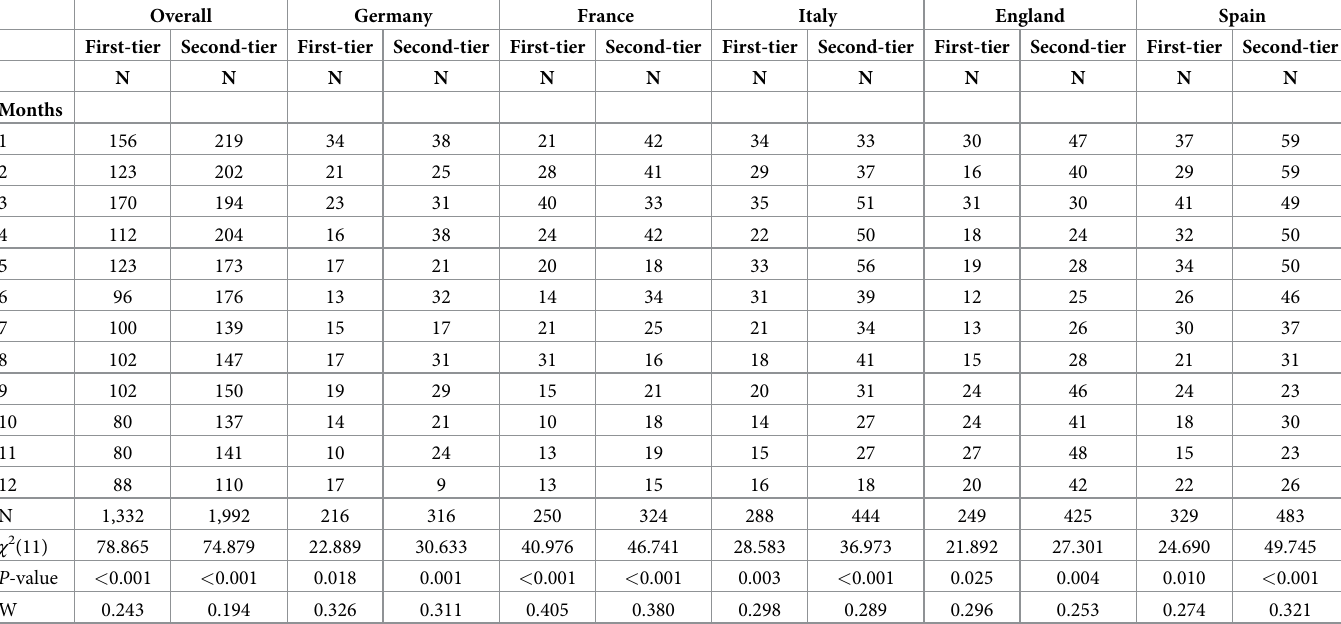
Table 1. Counts and χ 2 test of first- and second-tier players for the overall sample and for each country